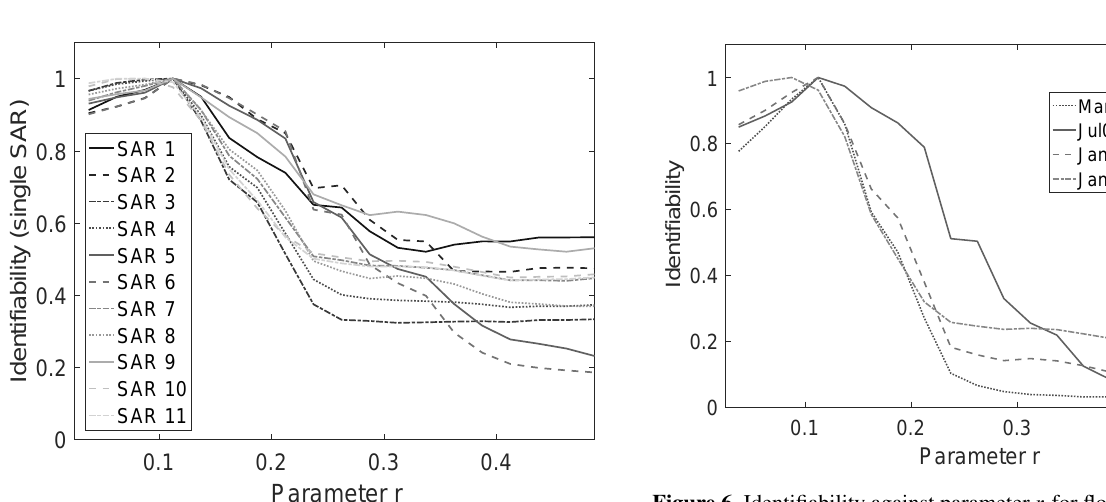
Figure 6. Identifiability against parameter r for flood